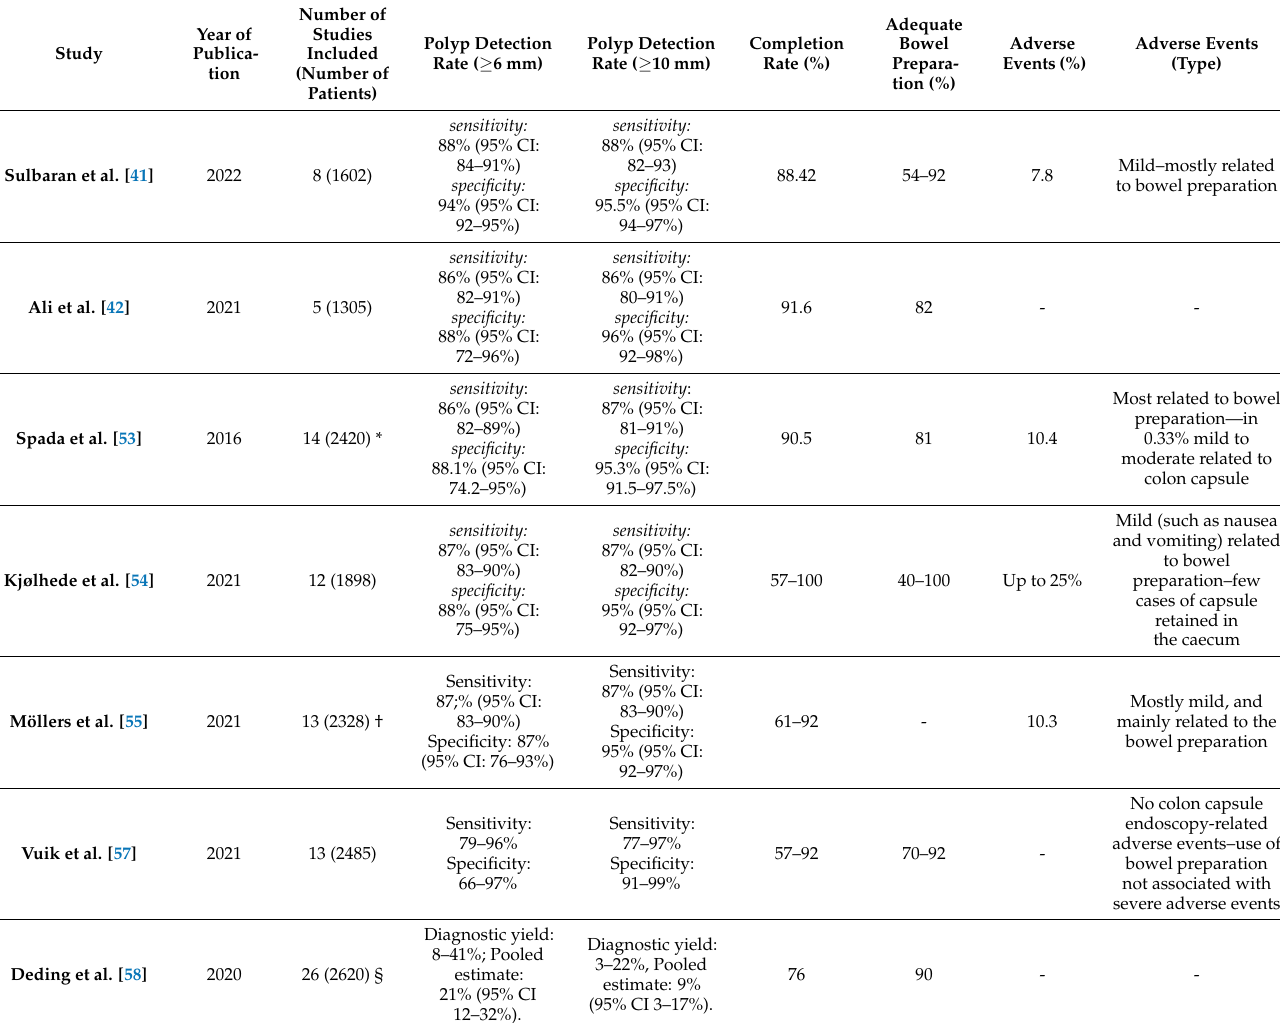
Table 2. Overview of recent systematic reviews and meta-analyses on colon capsule endoscopy and colon polyp